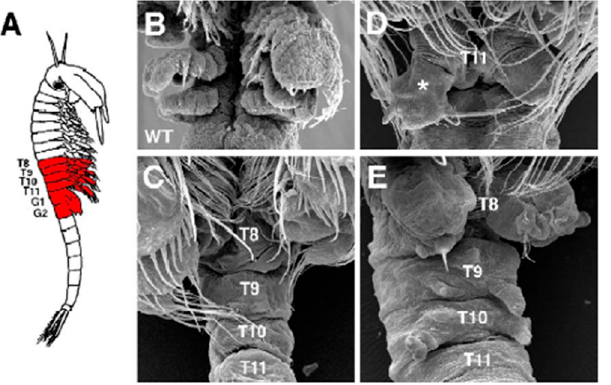
Figure 15. Artemia franciscana spalt RNAi modi fi ed phenotypes: malformed, rudimentary and missing appendages of di ff erent regions of the body. Panel ( A ) shows a highlight of the region of the body where malformed, rudimentary or missing appendages happen, together with posterior thoracic (T8–T11) and genital (G1 and G2) segments. ( B ) shows the scanning electron microscopy (SEM) of the thoracic appendages in a normal individual during mid-larval stages, presenting the characteristic morphology of juvenile, growing phyllopodous appendages. ( C – E ) show the SEM of dsRNA- treated individuals in late larval stages: ( C ) an individual with missing appendages in segments T9-T11; ( D ) an individual with a malformed appendage (marked by an asterisk) in the T11 segment, presenting clear abnormalities compared to normal phyllopodous appendages or to juvenile appendages (compare to panel B); ( E ) an individual with rudimentary and malformed (in T9 and T10) or missing (in T11) thoracic appendages. The anterior side is shown in all the panels [148].